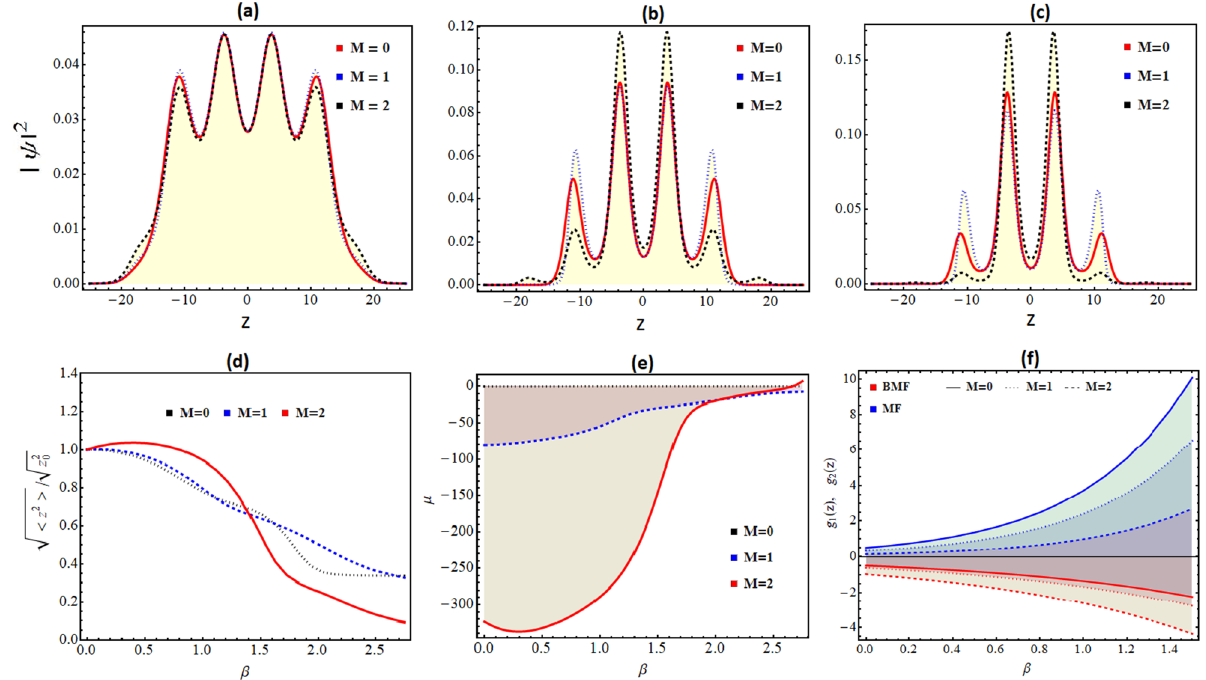
Figure 5. Variation of condensate density patterns for expulsive harmonic oscillator and BOL with respect to 0.25 ; ( b ) β 0.99 , ( c ) β 1.25 . ( d ) Variation of condensate rms size with β and illustrating the M for ( a ) β = = = droplet to soliton crossover. ( e ) Change in energy with changing β for M and BMF is plotted with changing β . Here, the magnitude of physical parameters: γ 0 0.999999 , E 2 / 9 . The spatial coordinate is scaled by the oscillator G 2 = = −